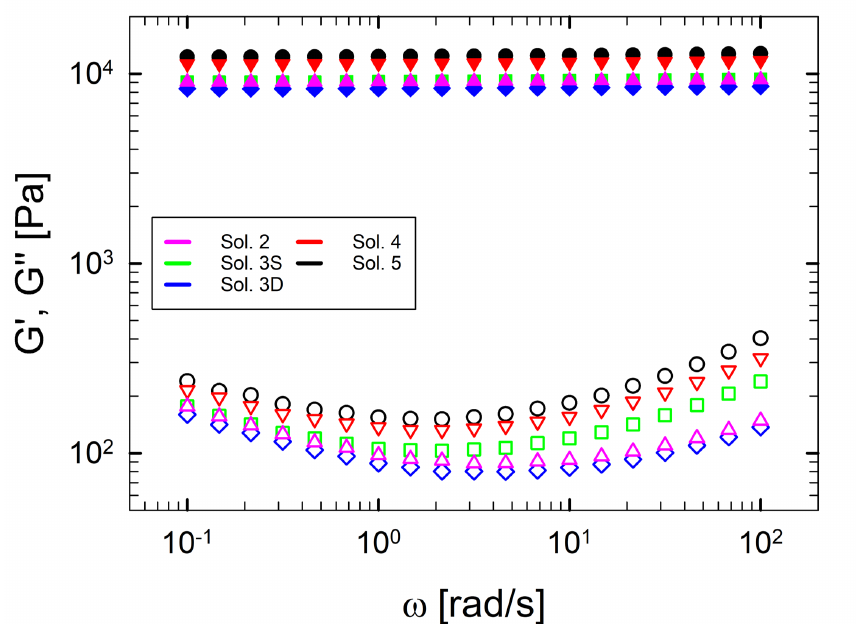
Figure 5. Linear viscoelasticity as a function of frequency at 5 °C for each multi-component gelatin solution. G (cid:48) is represented with filled symbols, G (cid:48)(cid:48) with empty symbols. Data are obtained after a soaking time of 1 h at 5